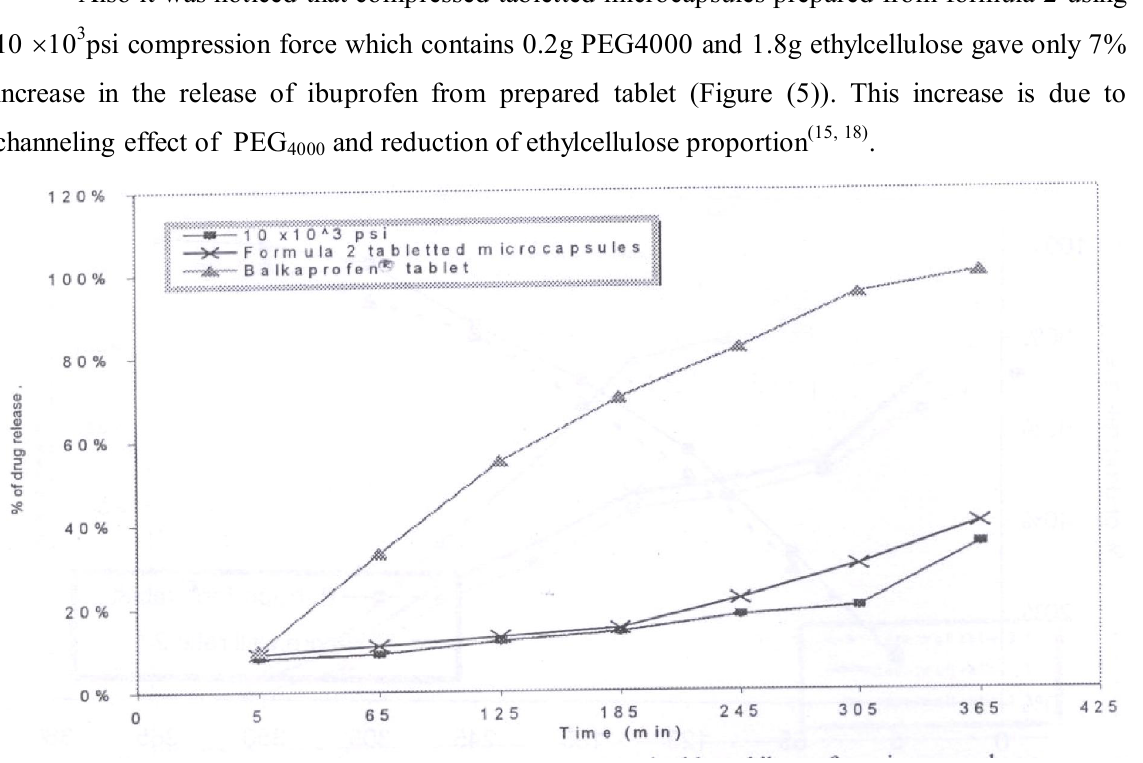
Figure (5): Dissolution behavior of compressed tabletted ibuprofen microcapsules (formula 2) and original compressed formula at a compression force of (10x10 3 spi) in comparison with Balkaprofen ® tablet using pH 6.8 phosphate buffer at